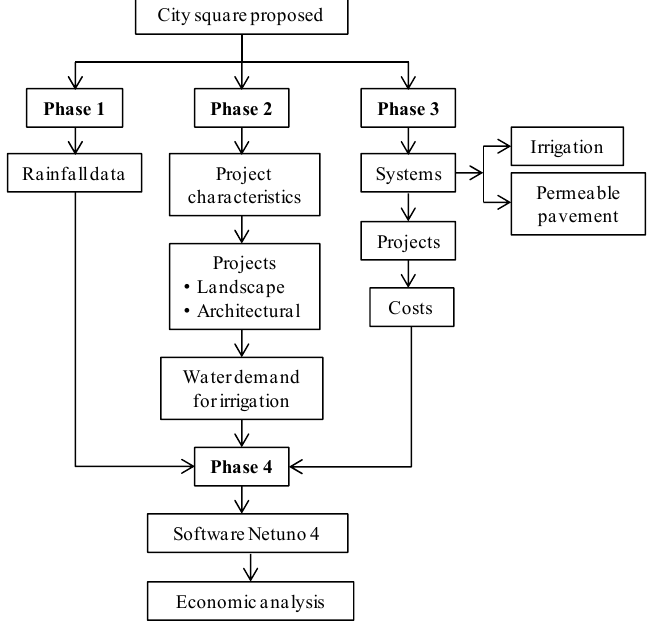
Figure 1. Flowchart of the methodology.